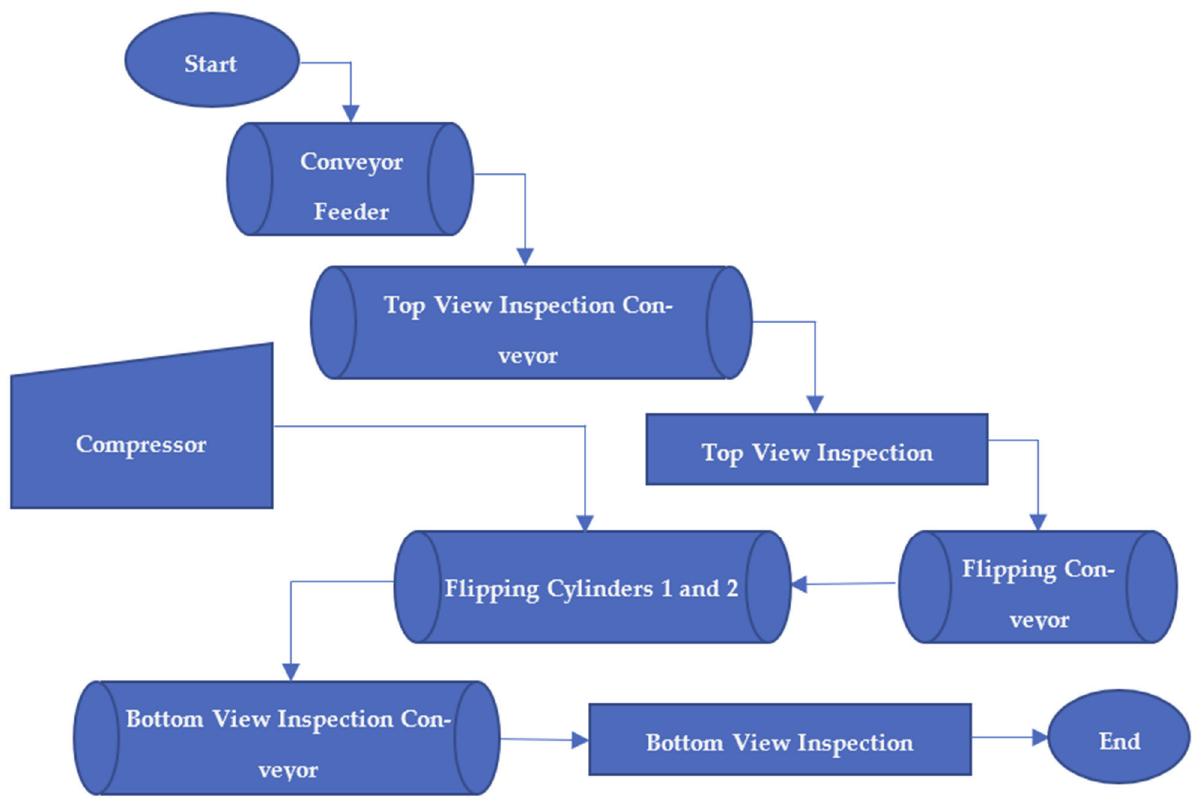
Figure 3. Process flow diagram on new roof tile transportation and inspection system.